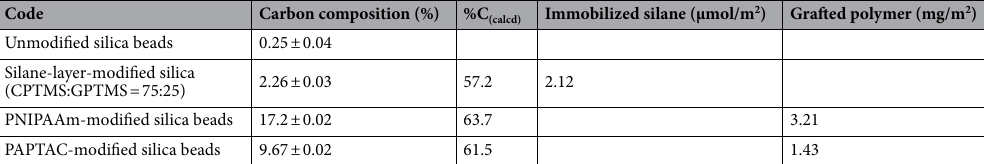
Table 1. Characterization of the silane layer and polymer-modified beads. The carbon composition of the beads was determined through elemental analysis (n = 3). %C (calcd) was calculated as the percentage of the molecular weight of carbon in the silane layer and polymer. The amount of layered silane and polymer on silica beads was estimated using the measured carbon composition.